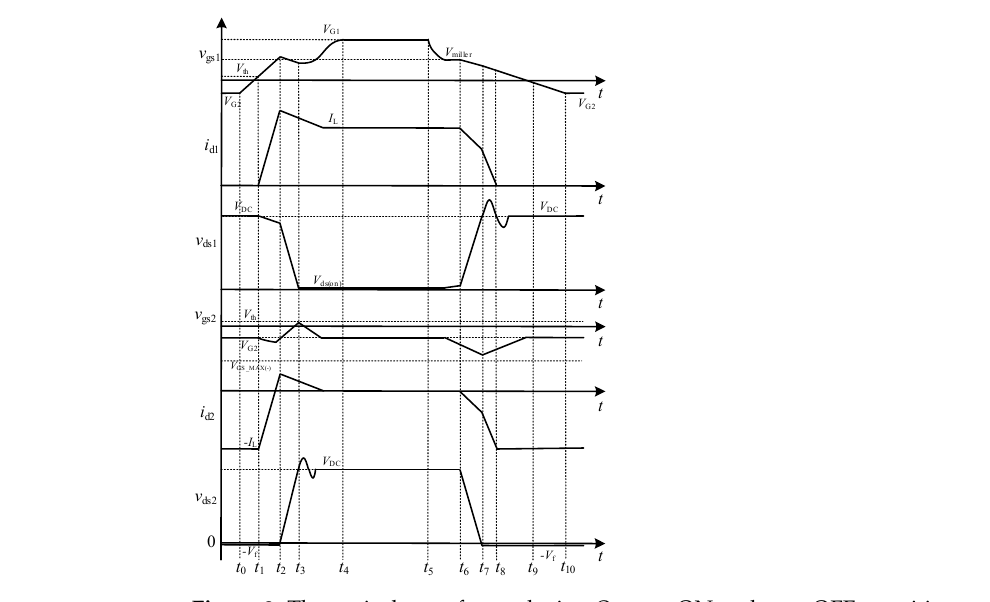
Figure 3. Theoretical waveforms during Q 1 turn-ON and turn-OFF transition.